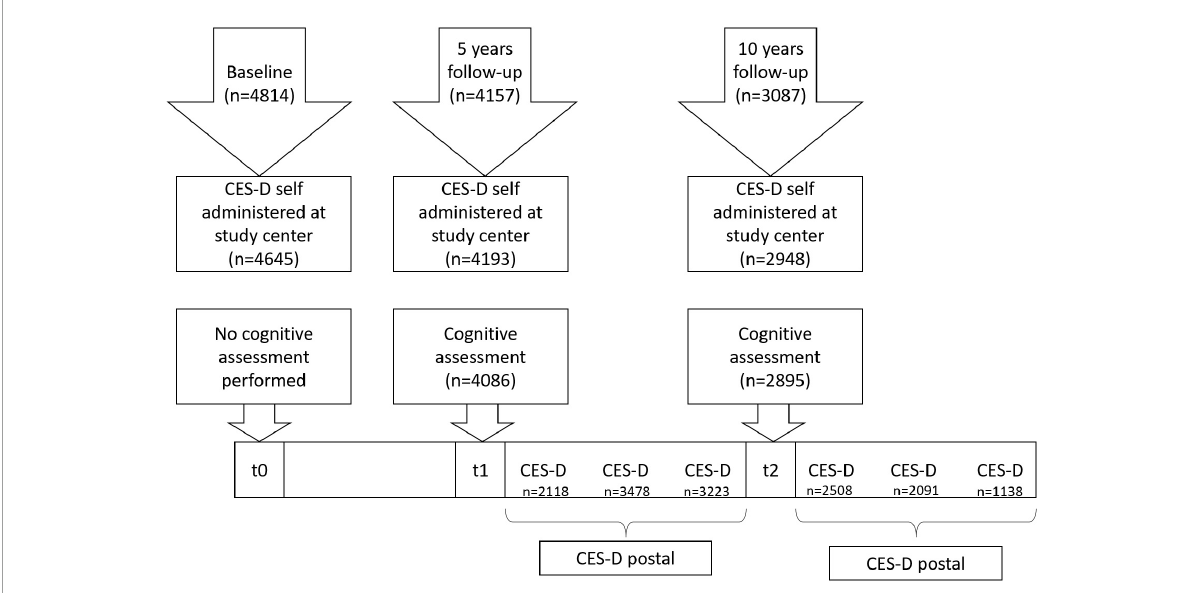
FIGURE1 Timeline of the Heinz Nixdorf Recall study, Center for Epidemiologic Studies Depression Scale (CES-D), and cognitive assessments [for details see Engel et al. (2020)].